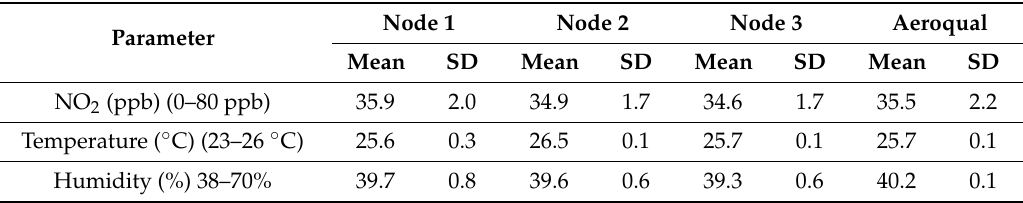
Table 2. Means and standard deviations for three parameters.